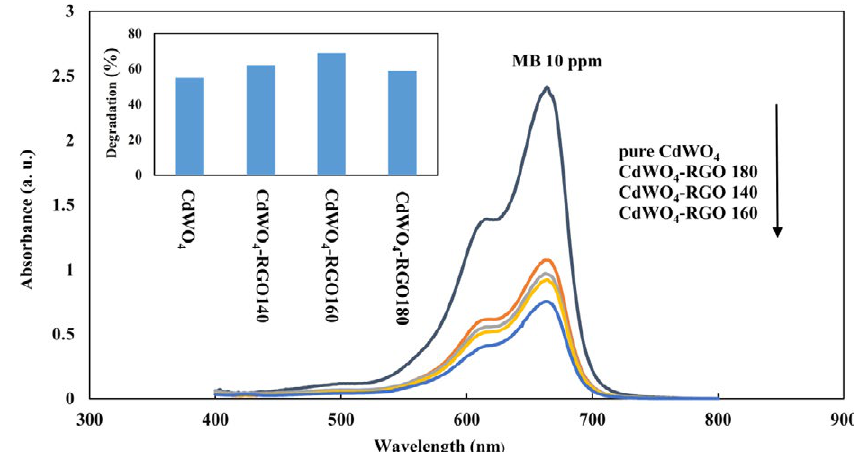
Fig. 8 The photocatalytic degradation of MB in the presence of the pure CdWO